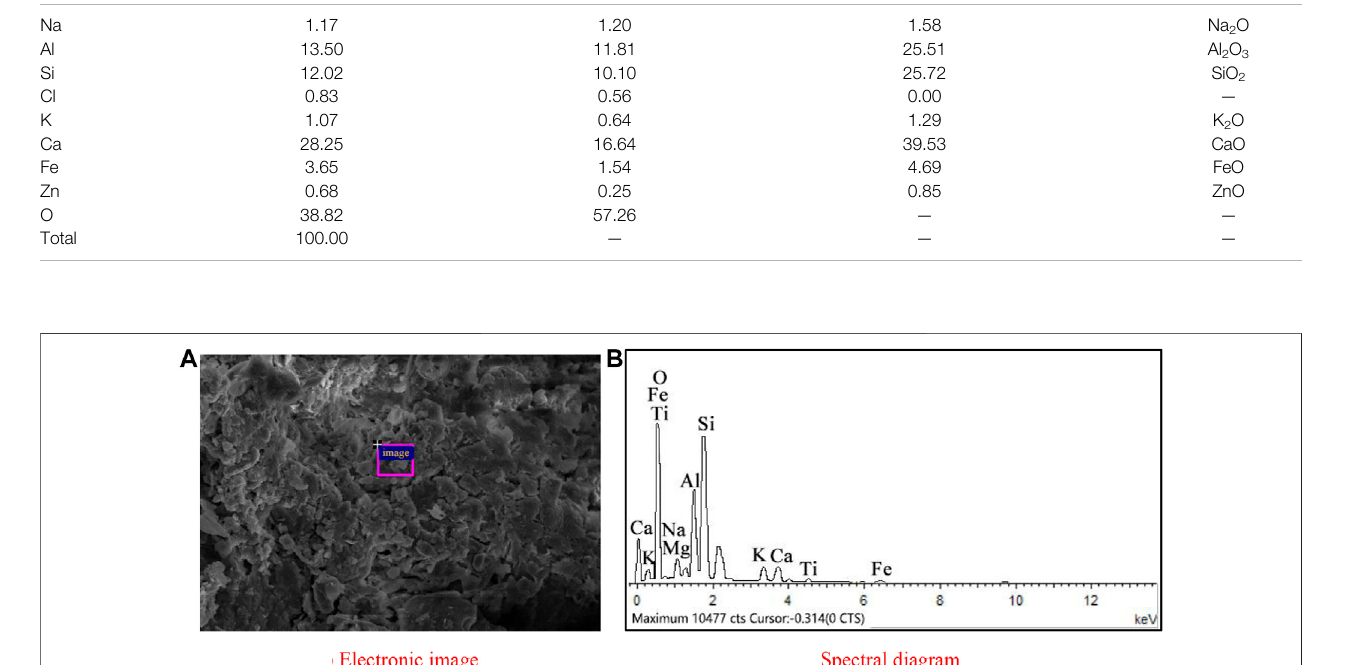
TABLE5| Elementalcompositionforselectedareasintheone-partgeopolymer-stabilizedsoilsamplewith90%GGBFSand10%FAat4.64 mol/LNHsolutionforC-A-Hor C-A-S-H. Element Weight percentage Atomic percentage